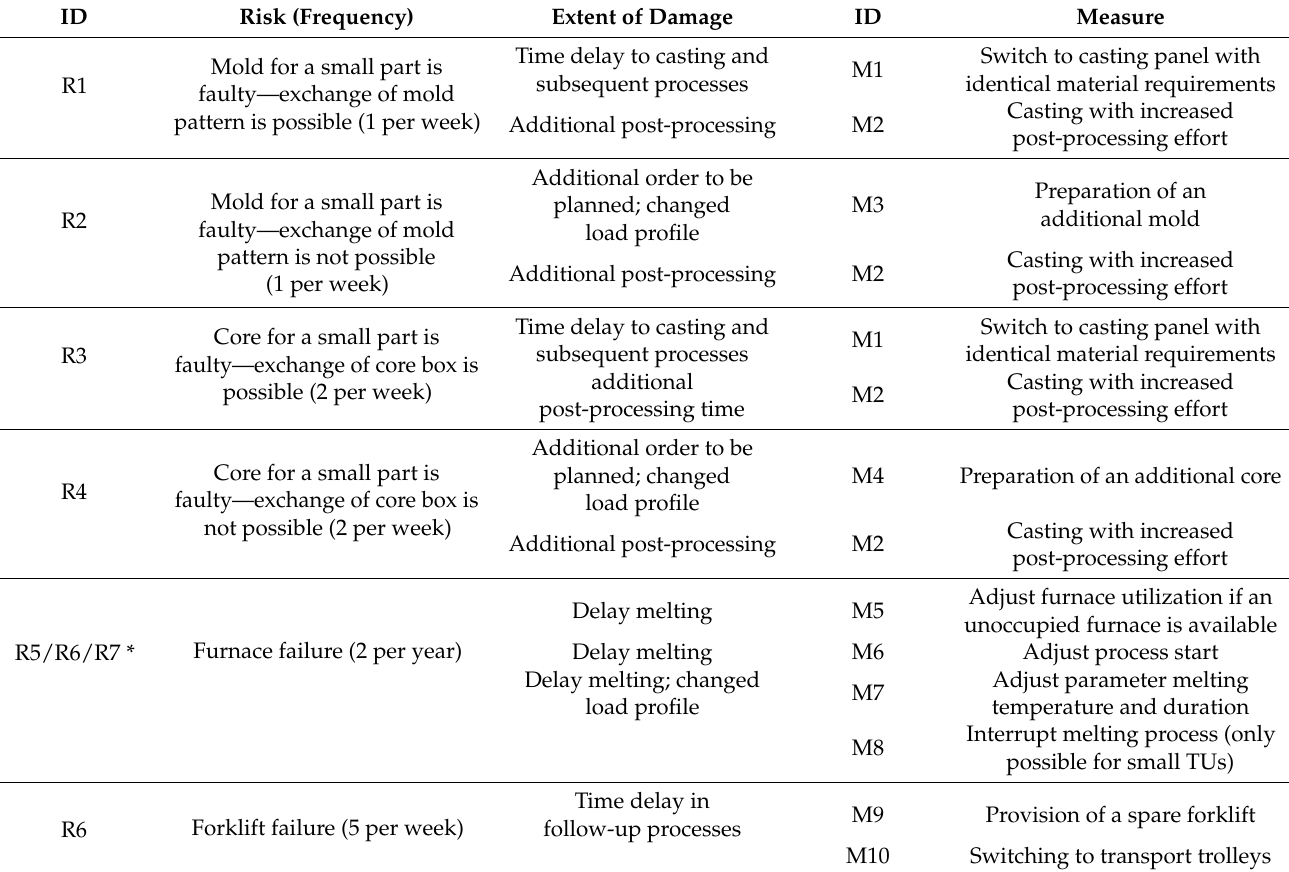
Table 3. Risk inventory with the frequency of occurrence, extent of damage, and the related